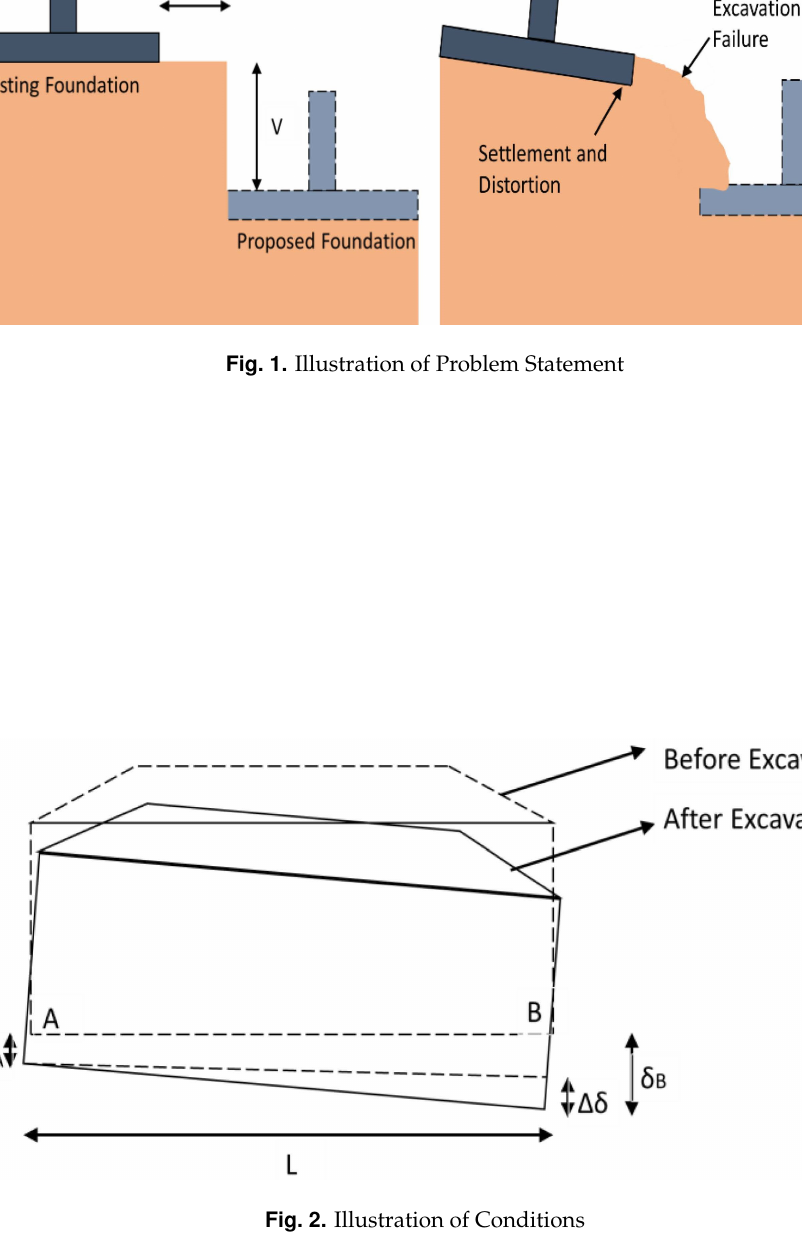
Fig. 2. Illustration of